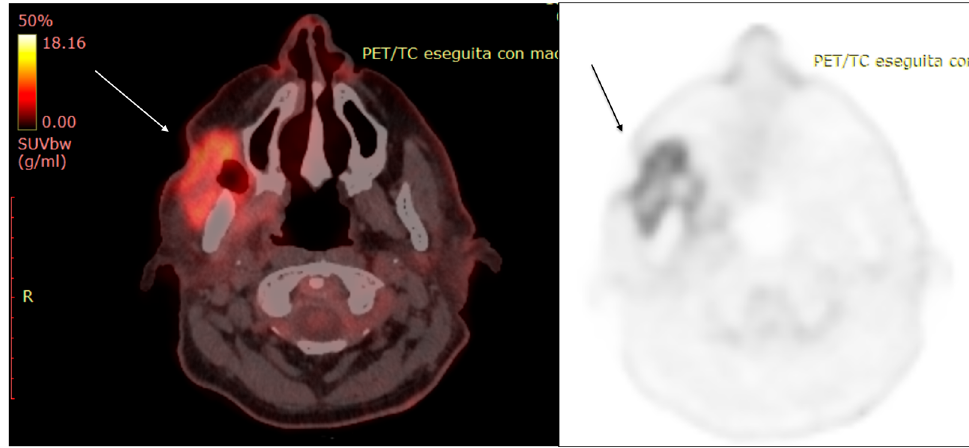
Figure 8. A 53-year-old female patient, PET/TC examination. The exam confirms a cutaneous and subcutaneous lesion with bone involvement.